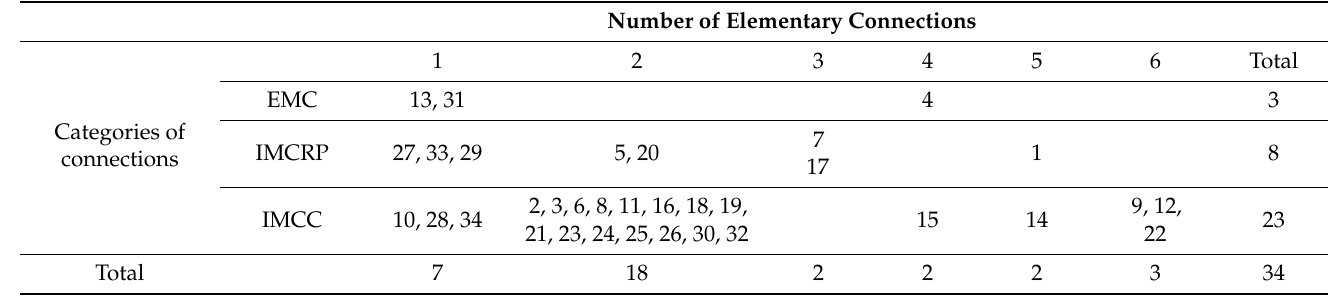
Table 2. Complex classroom connections (CC) identified in study 2 and number of elementary connections that form them.